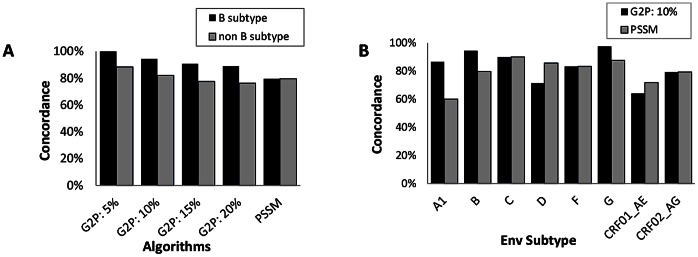
Concordance between tropism measured phenotypically and inferred genotypically using the Geno2pheno(coreceptor) and webPSSM algorithms.(A) Concordance for subtype B (black bars) and non-B subtype (grey bars) strains with Geno2Pheno (G2P) at different FPR cutoffs and webPSSM. (B) Concordance with Geno2pheno(coreceptor) with a FPR set at 10% (black bars) and webPSSM (grey bars) for different HIV-1 subtypes. The webPSSM X4/R5 matrix was used for all subtypes, except for subtype C, for which the subtype C SI/NSI matrix was used.